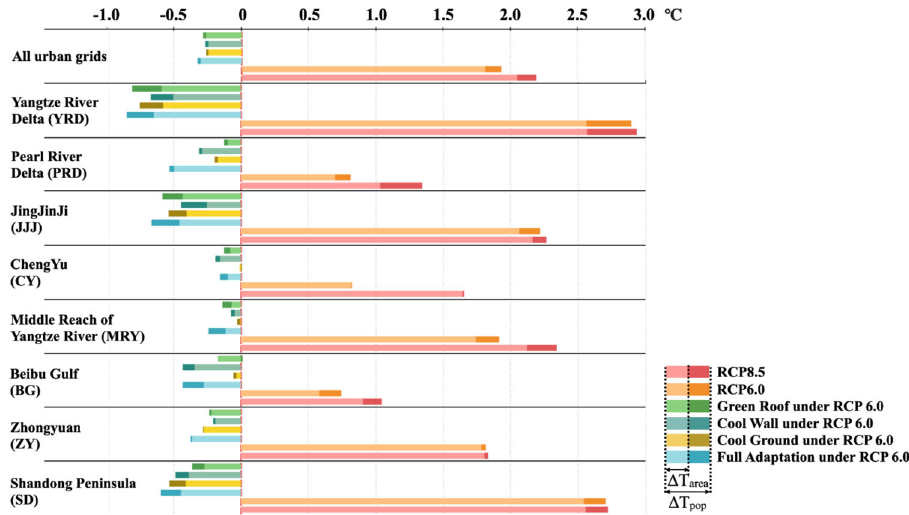
Fig. 1 Changes in the average wet-bulb global temperature in shadow (WBGTs) value during the possible working times (8:00 – 20:00) in summer by the 2050s relative to the 2010s. The associated scenarios are RCP 6.0 ( a ) and RCP 8.5 ( b ). Each point indicates the value in each urban grid (the urban land-use fraction is projected to be higher than that of any other land-use type in each grid by the 2050s) at a 20-km